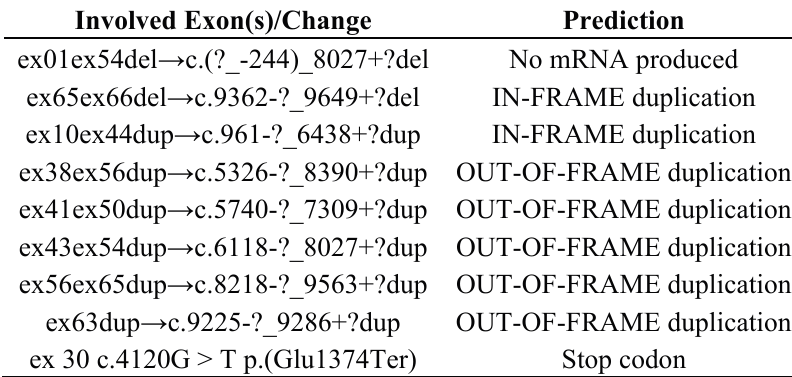
Table 2. Novel mutations found in Mexican-Mestizo DMD